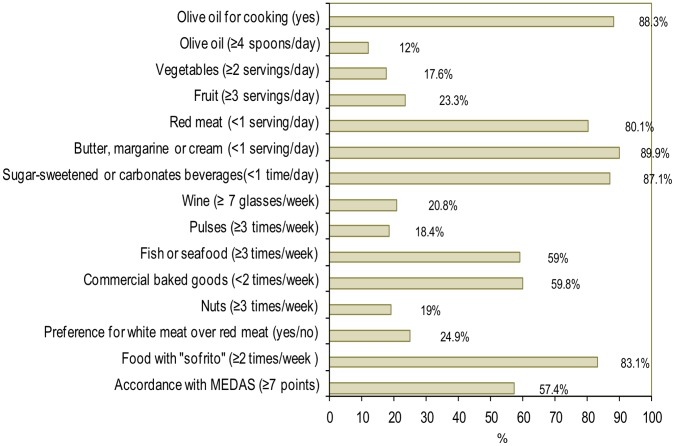
Accordance with the Mediterranean diet.Percentage of diagnosed diabetic subjects who achieved each target of the Mediterranean Diet Adherence Screener (MEDAS) and accordance with the Mediterranean diet. Bars represent 95% confidence intervals. Sofrito: Sauce made with tomato and onion, leek, or garlic and sautéed in olive oil.